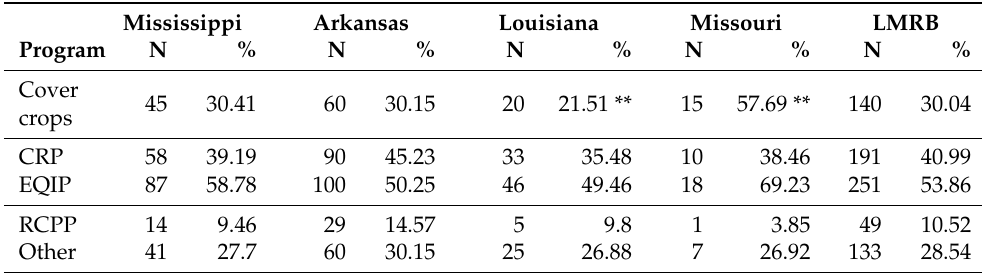
Table 4. Summary statistics of farmers growing cover crops and participating in government- sponsored conservation programs in the Lower Mississippi River Basin (LMRB) in 2016.